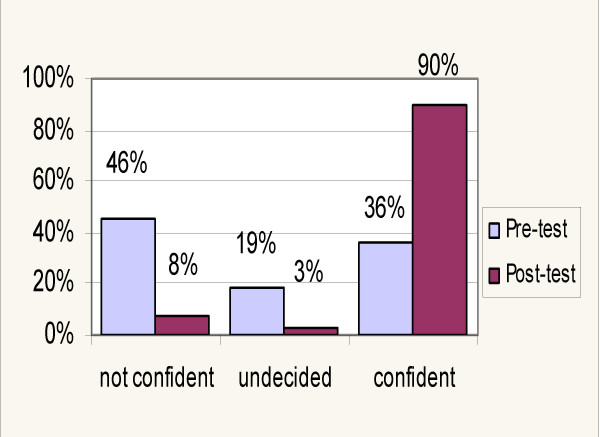
Conducting brief intervention for risky alcohol use.